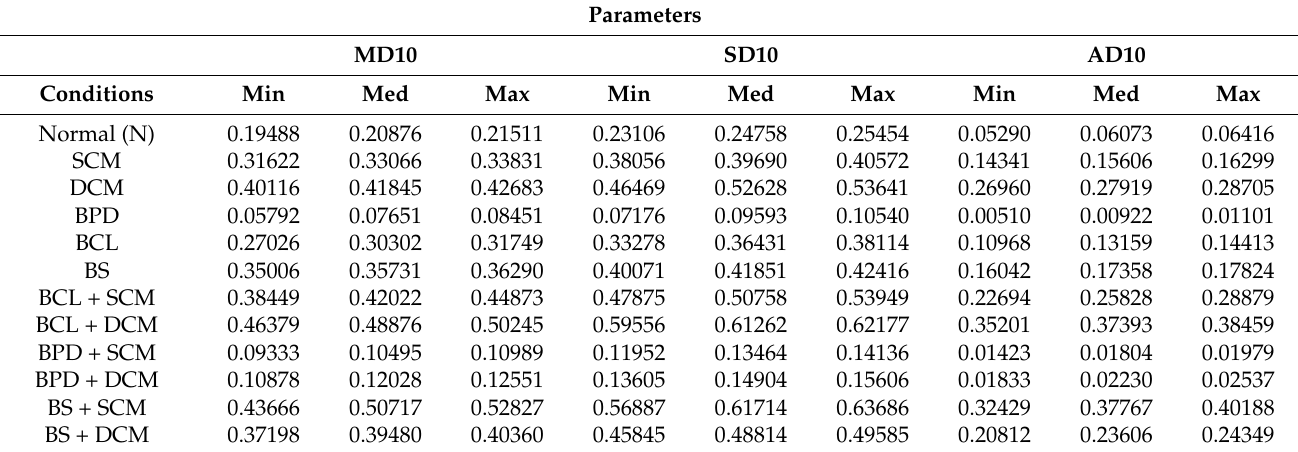
Table 4. Minimum, average and maximum values of the MRA parameters.